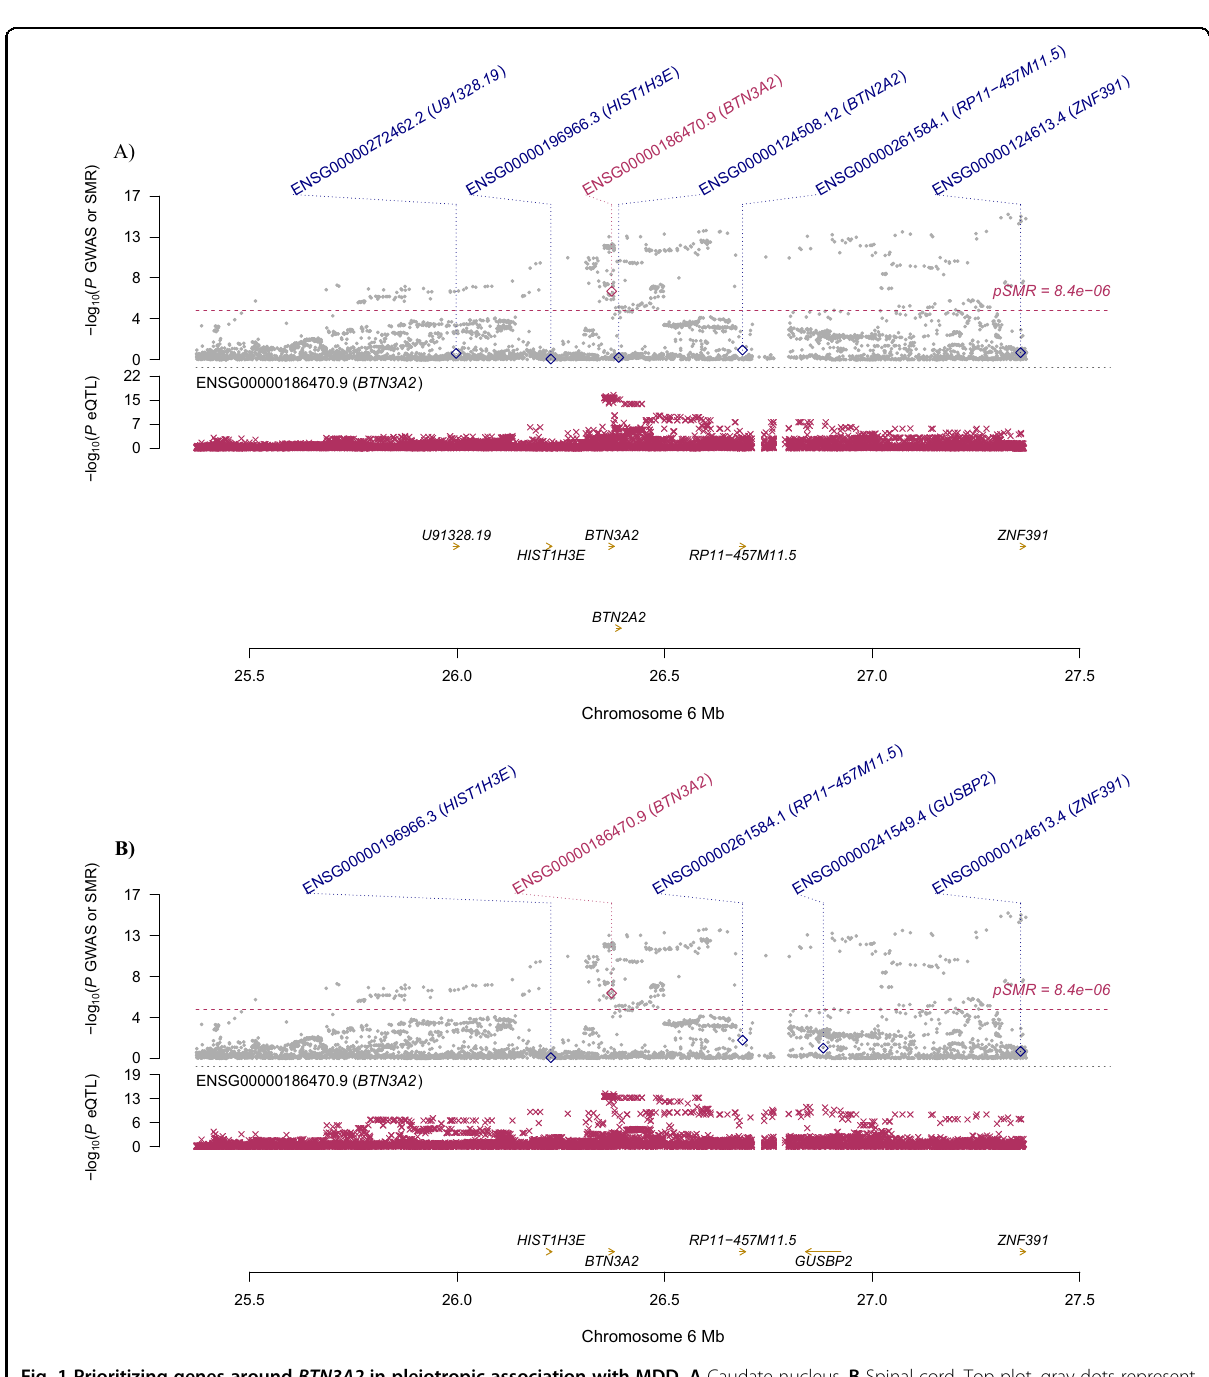
Fig. 1 Prioritizing genes around BTN3A2 in pleiotropic association with MDD. A Caudate nucleus. B Spinal cord. Top plot, gray dots represent the − log 10 ( P values) for SNPs from the GWAS of MDD, and rhombuses represent the − log 10 ( P values) for probes from the SMR test with solid rhombuses indicating that the probes pass HEIDI test and hollow rhombuses indicating that the probes do not pass the HEIDI test. Middle plot, eQTL results for the probe ENSG000001864770.9 tagging BTN3A2 . Bottom plot, location of genes tagged by the probe. Highlighted in maroon indicates probes that pass the SMR threshold. GWAS genome-wide association study, MDD major depressive disorder, SMR summary data-based Mendelian randomization, HEIDI heterogeneity in dependent instruments, eQTL expression quantitative trait